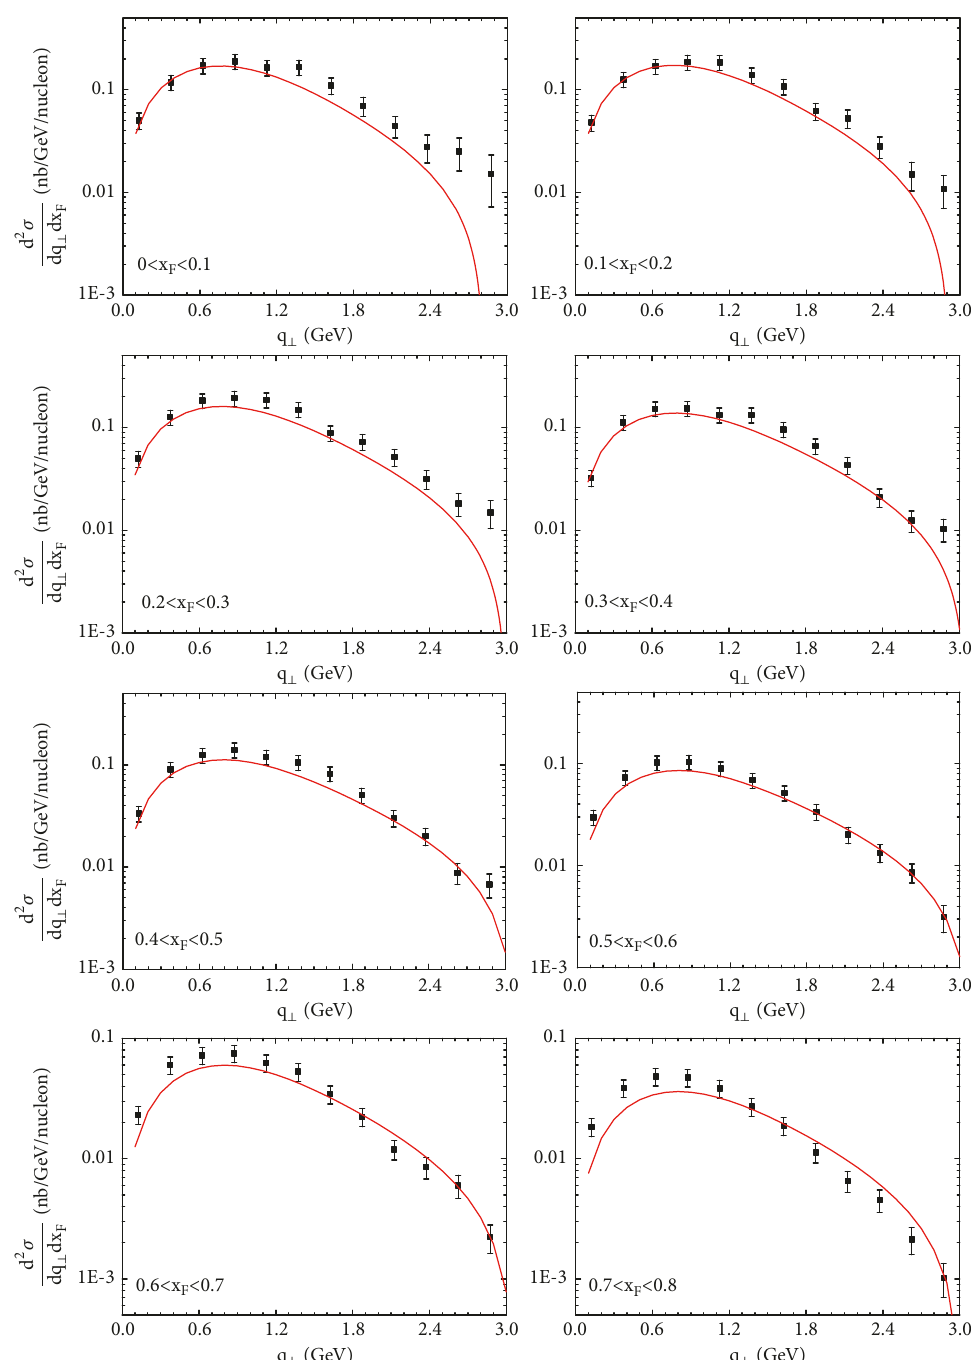
Figure 1: The fitted cross section (solid line) of pion-nucleon Drell-Yan as functions of 𝑞 ⊥ , compared with the E615 data (full square), for different 𝑥 𝐹 bins in the range 0 < 𝑥 𝐹 < 0.8 . The error bars shown here include the statistical error and the 16 % systematic error. Figure from